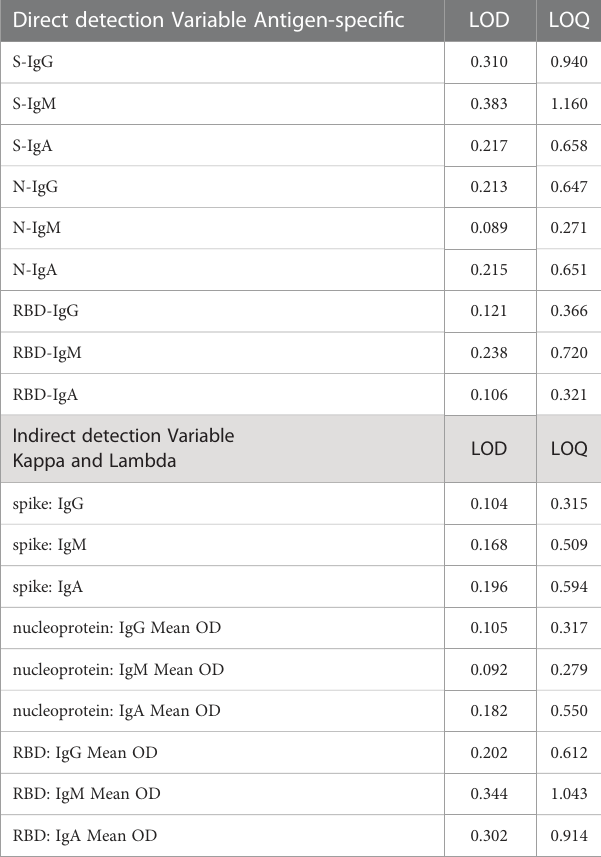
TABLE 3 ELISA “ limits of detection ” (LOD) and “ limits of quantitation ” (LOQ) using direct and indirect capture. Direct detection Variable Antigen-speci fi